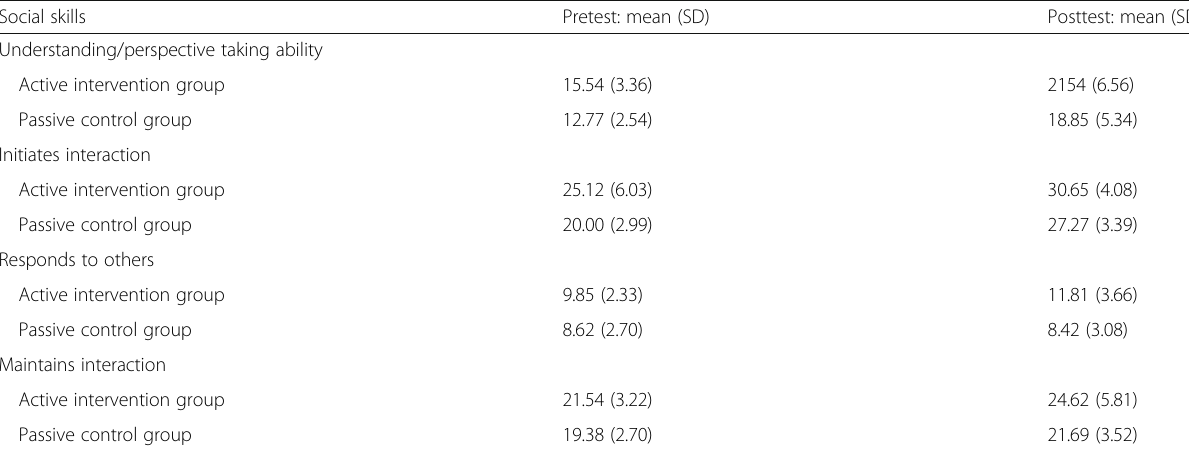
Table 2 Effect of MT on social skills rating Social skills Understanding/perspective taking